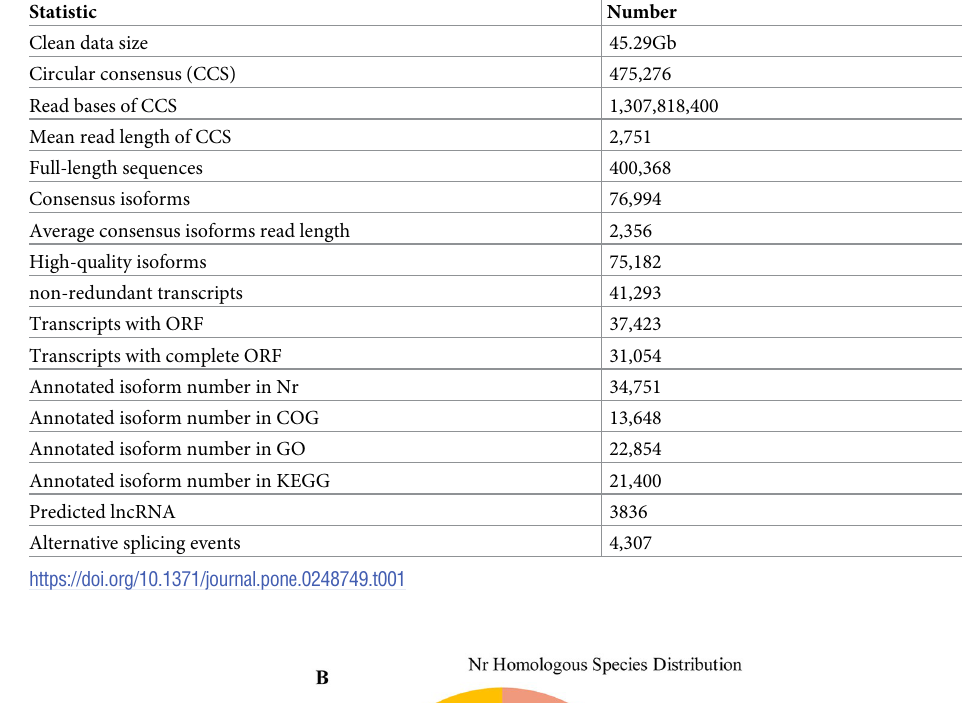
Table 1. Statistics of full-length transcriptome sequencing.